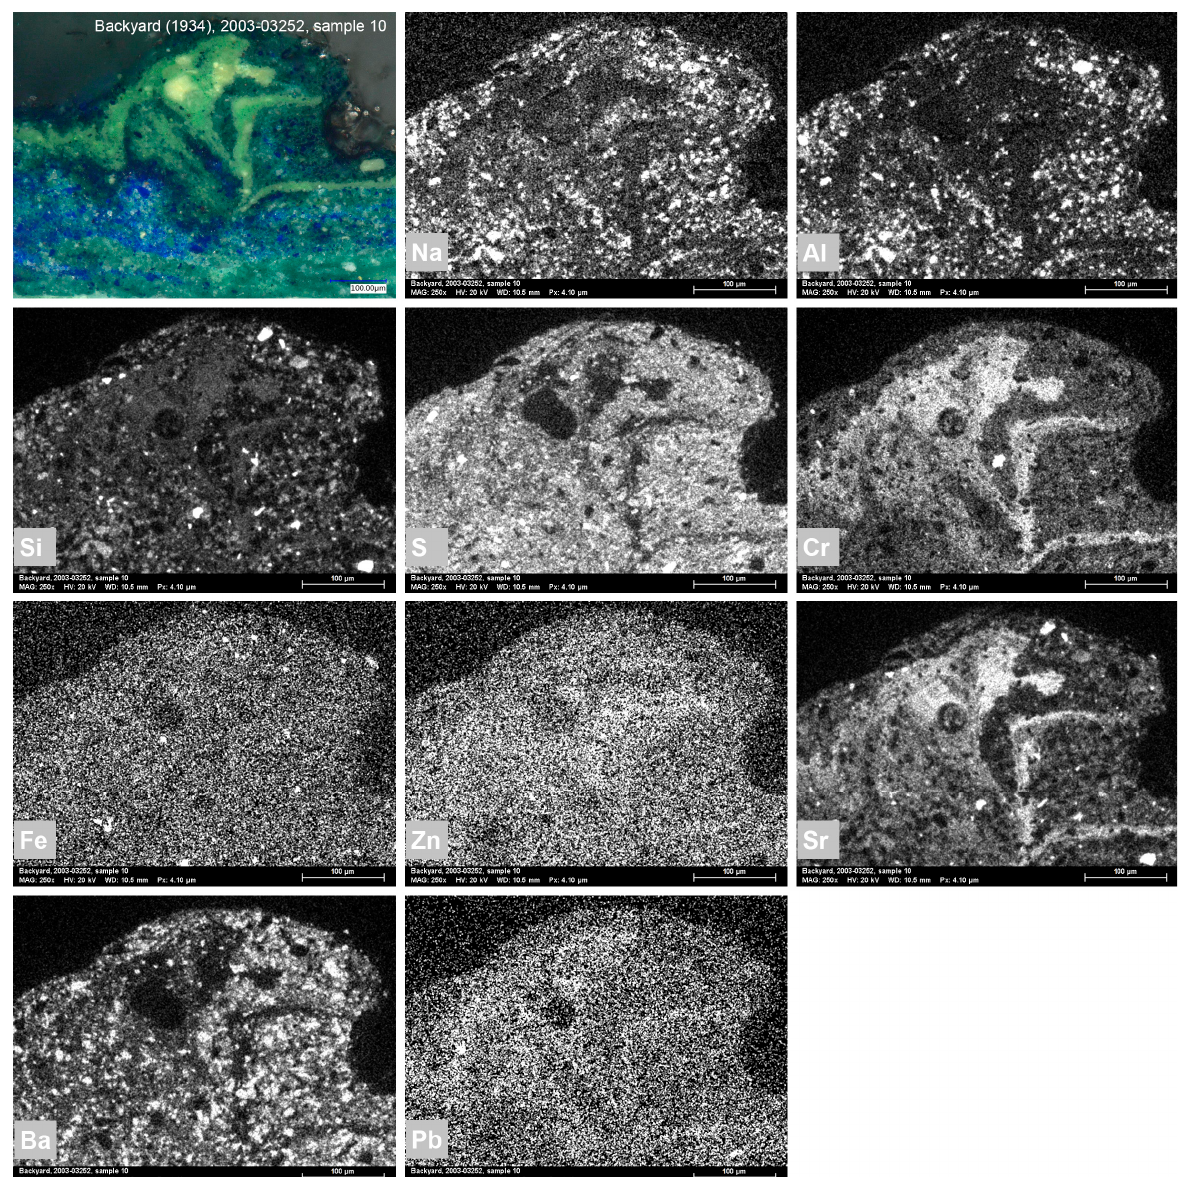
Figure 12. Optical microscopy image of the cross-section of sample 10, extracted from Backyard , 1934 and captured at 250× magnification (top-left), followed by SEM-EDS elemental distribution maps. The intensity of the signal of each element is represented by a range of grey tones: white represents high intensity and black represents low intensity. A co-presence of highly intensive Cr- and Sr-signals may indicate the use of strontium yellow. Na, Al, Si and S elements may suggest a presence of ultramarine. Fe-signal is attributed to Prussian blue.